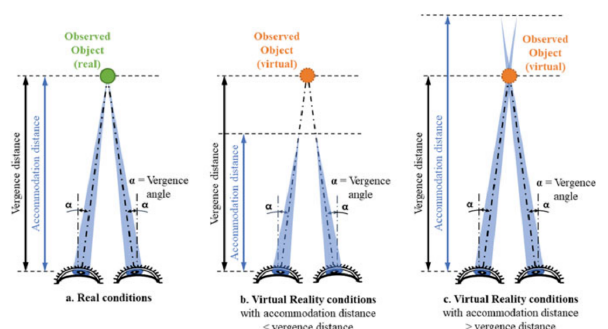
Figure 1. Kemeny’s vergence­accommodation conflict example. In natural conditions (a), vergence distance and accommodation distance are the same. In VR (b and c), the vergence distance produced by HMD frequently differs from the accommodation distance (Kemeny et al., 2020).